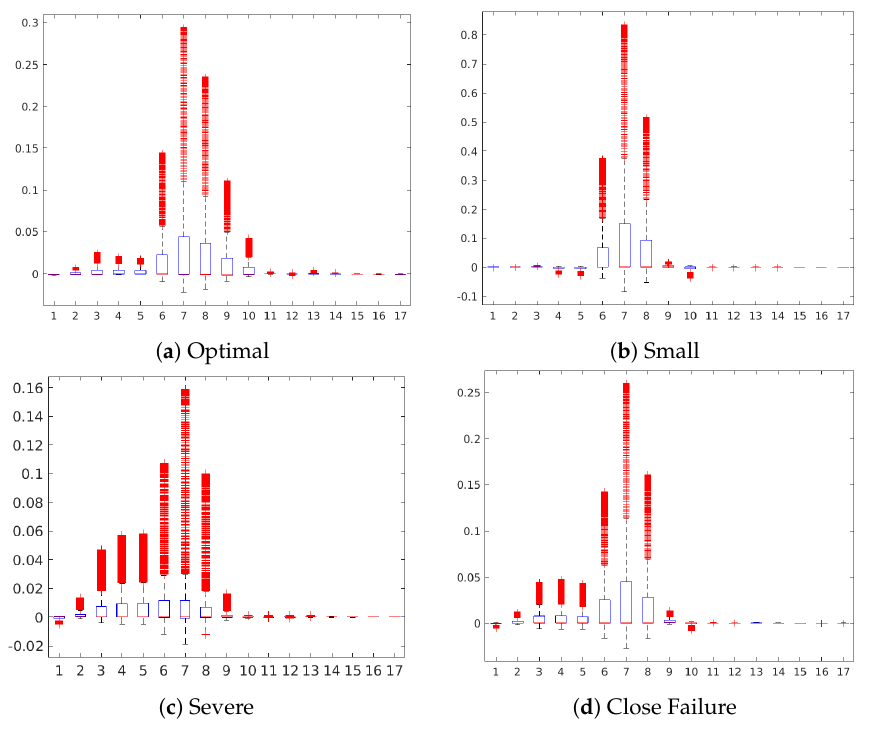
Figure 6. Boxplot of the sensor contributions for the Valve